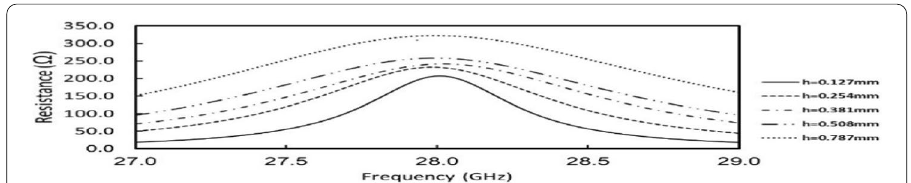
Fig. 3 Simulated real parts of the antenna input